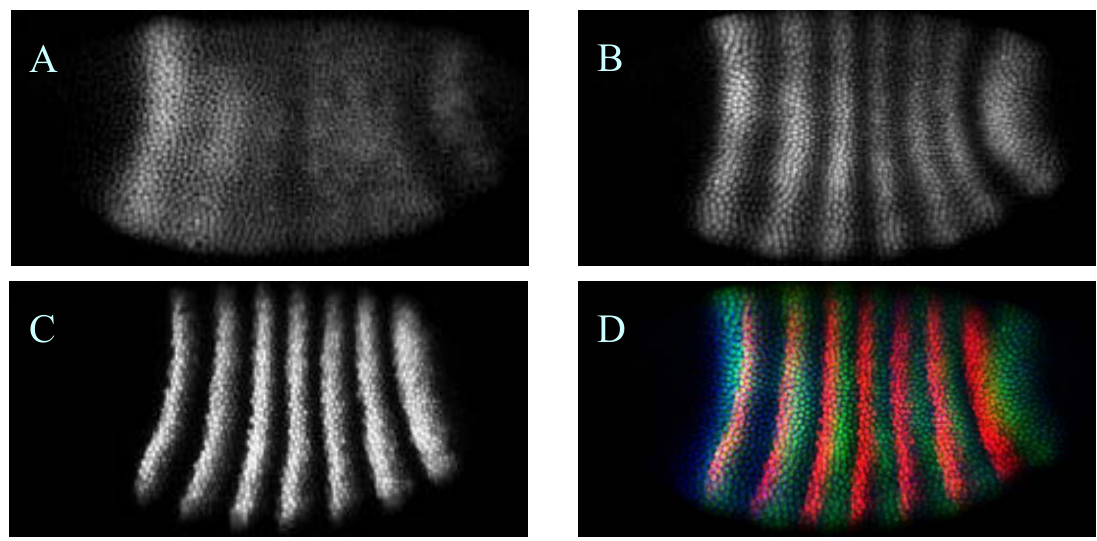
Figure 7: Temporal dynamics of expression of even-skipped gene. Expression patterns from 3 embryos of different age: (A) temporal class 1, (B) temporal class 4 and (C) temporal class 8. (D) is obtained by combining A, B and C, which are color coded as blue, green and red, correspondingly.